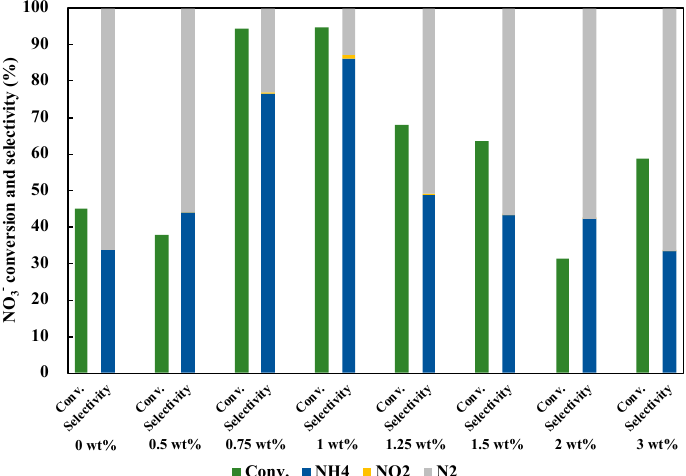
0102030405060708090100